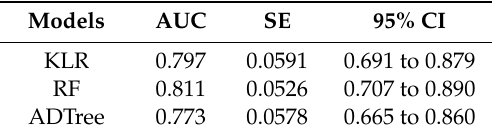
Table 6. Parameters of AUC values using validation dataset.